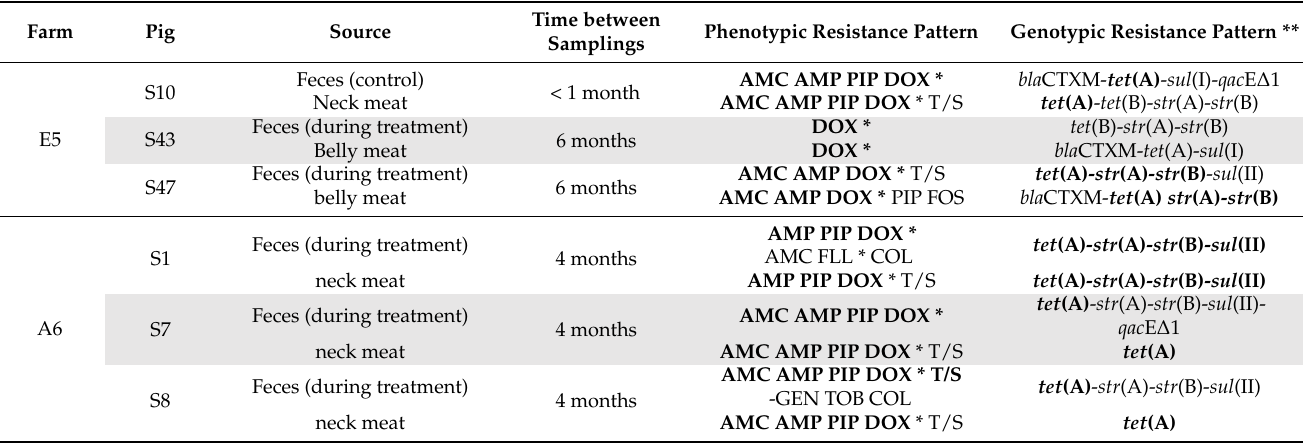
Table 16. Genotypic resistance patterns of E. coli from meat and feces (paired by pig of origin), which resembled each other in phenotypic AMS